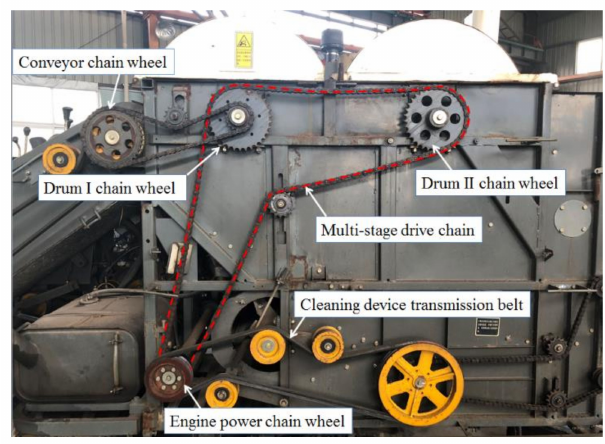
Figure 1. Double threshing drums structure and chain drive diagram of the combine